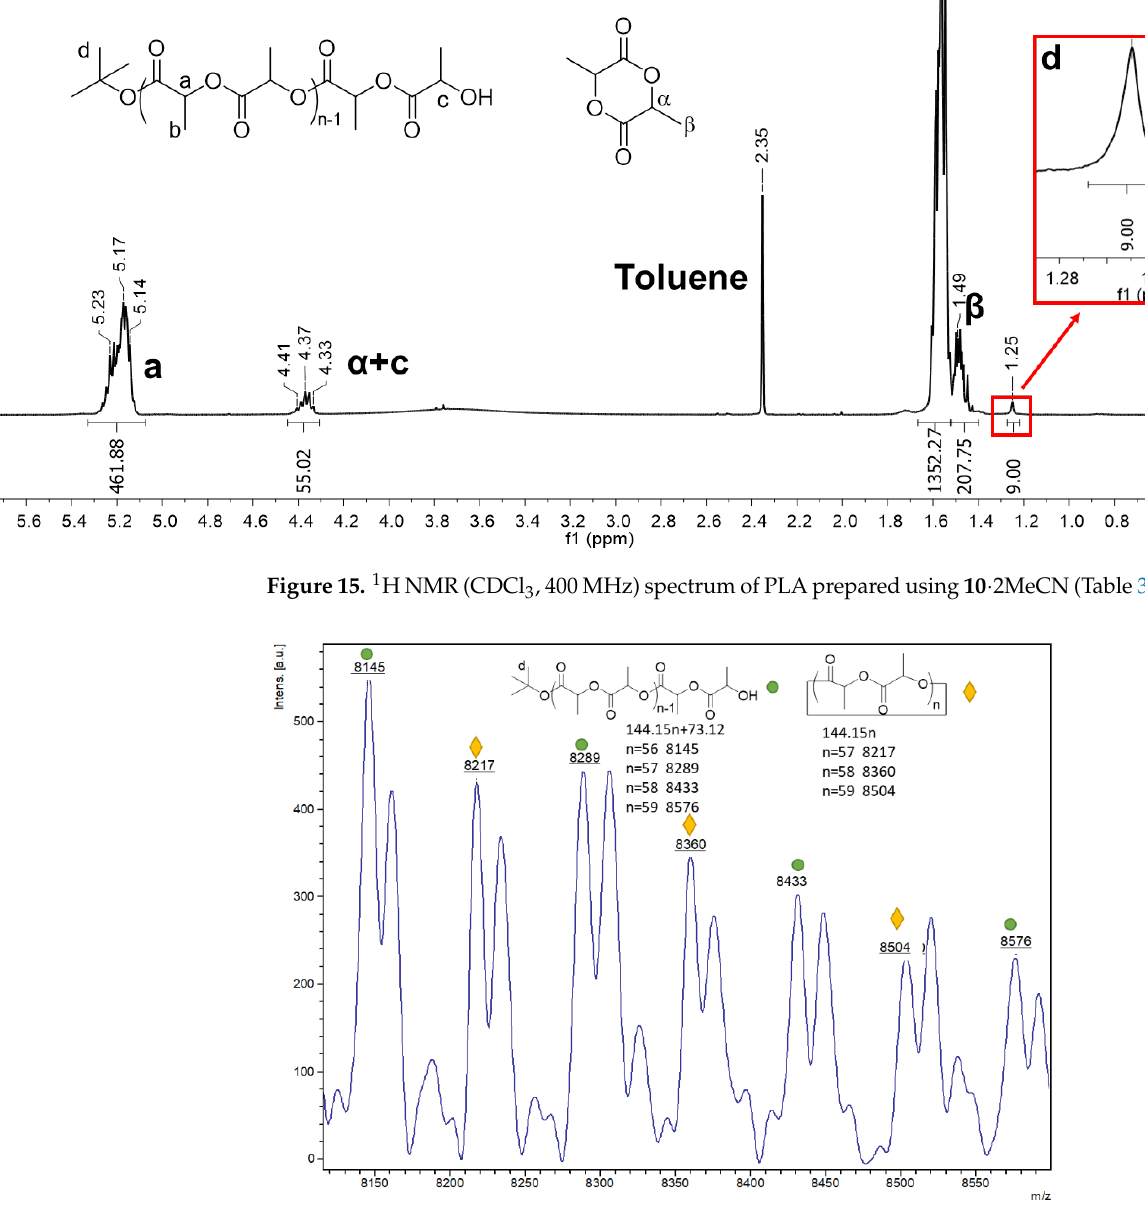
Figure 16. MALDI-TOF mass spectrum of PLA prepared using 10 · 2MeCN (Table 3, entry 10).